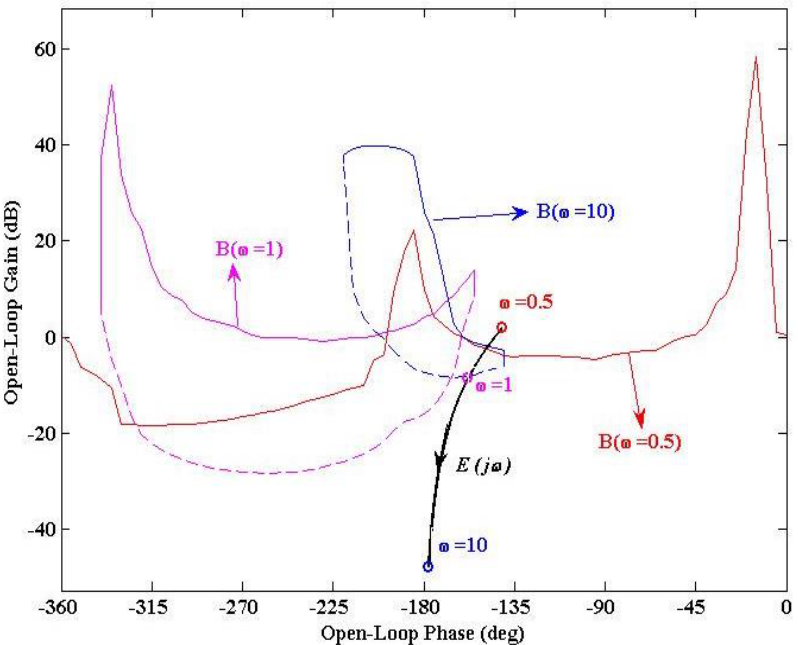
Figure 7. Design of anti-windup controller E using the bounds generated using the proposed design inequality (Equation (8)).